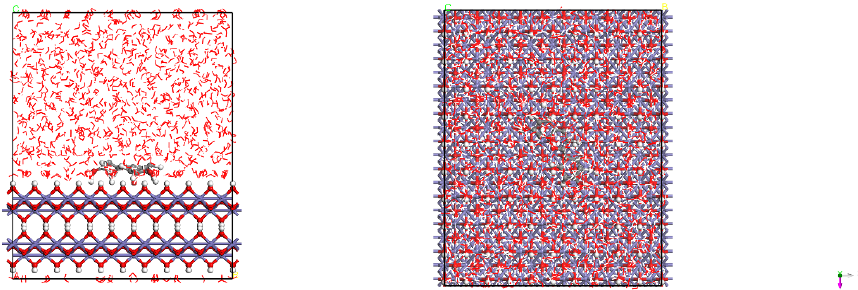
Figure 16. The adsorption configuration of luteolin molecule on γ -FeOOH (010) surface.